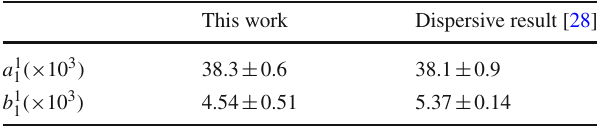
Table 11 P-wave threshold parameters in customary m π = 1 units. They are almost indistinguishable for solutions I, II and III